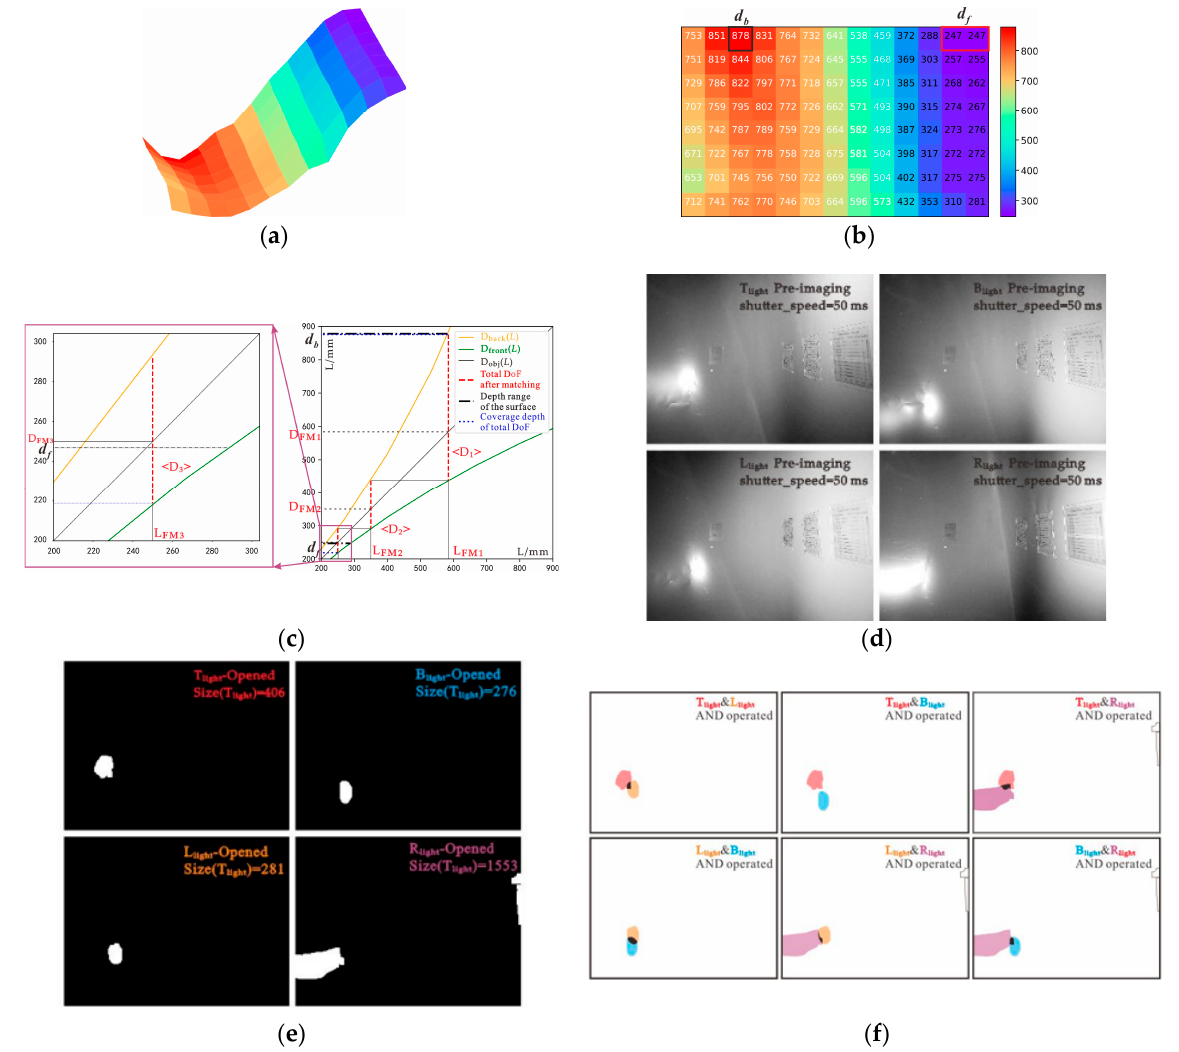
Figure 12. Decision-making process under viewpoint iii; ( a ) surface simulation; ( b ) data of depth distribution; ( c ) all-in-focus imaging scheme; ( d ) images of pre-imaging; ( e ) pre-imaging images after “open operation”, where the four different colors in this figure represent the different light sources. For example, the image with a red color character represents the image obtained under the T light , and the blue, orange, and purple colors represent B light , L light , and R light respectively. ( f ) Inferred